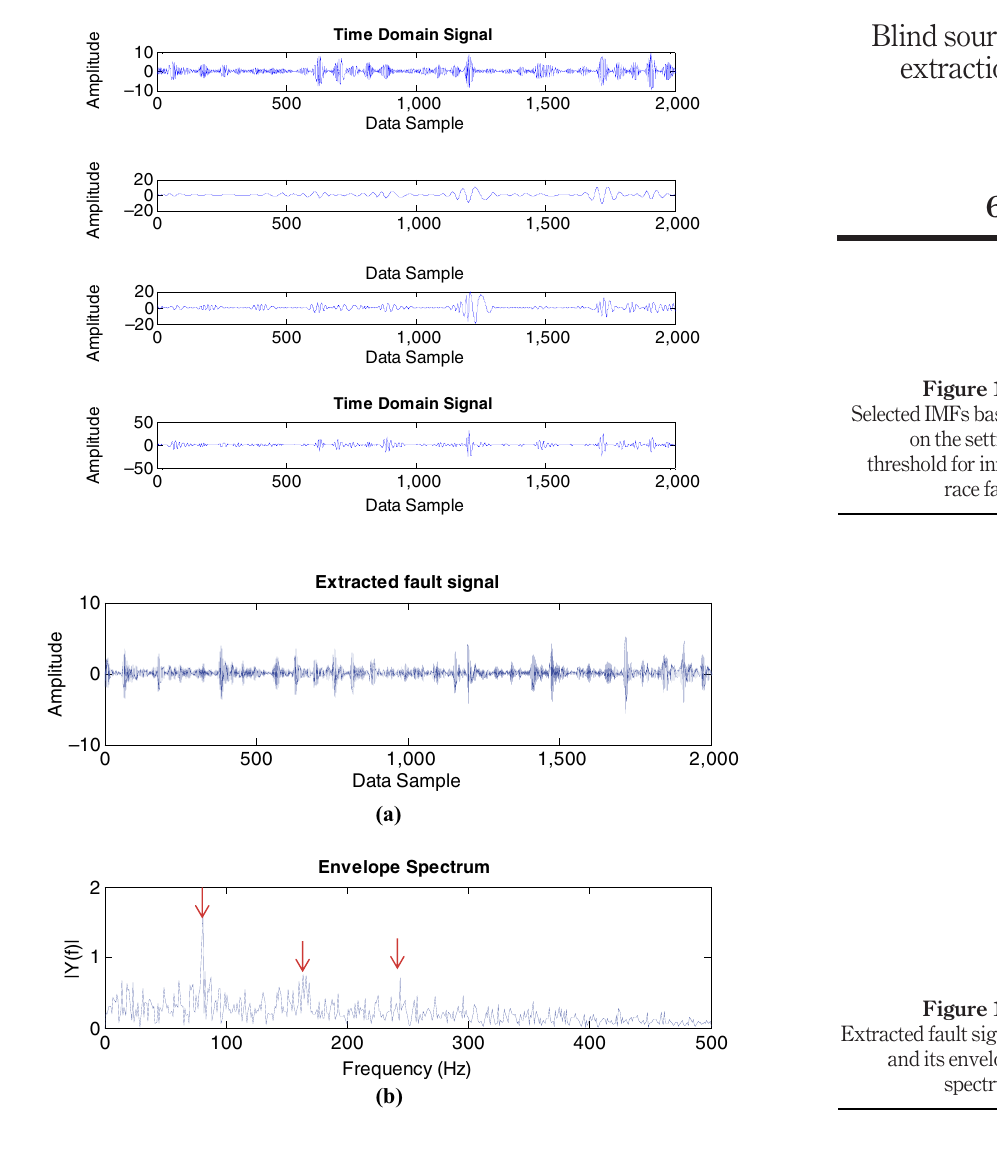
Figure 10. Selected IMFs based on the setting threshold for inner race fault